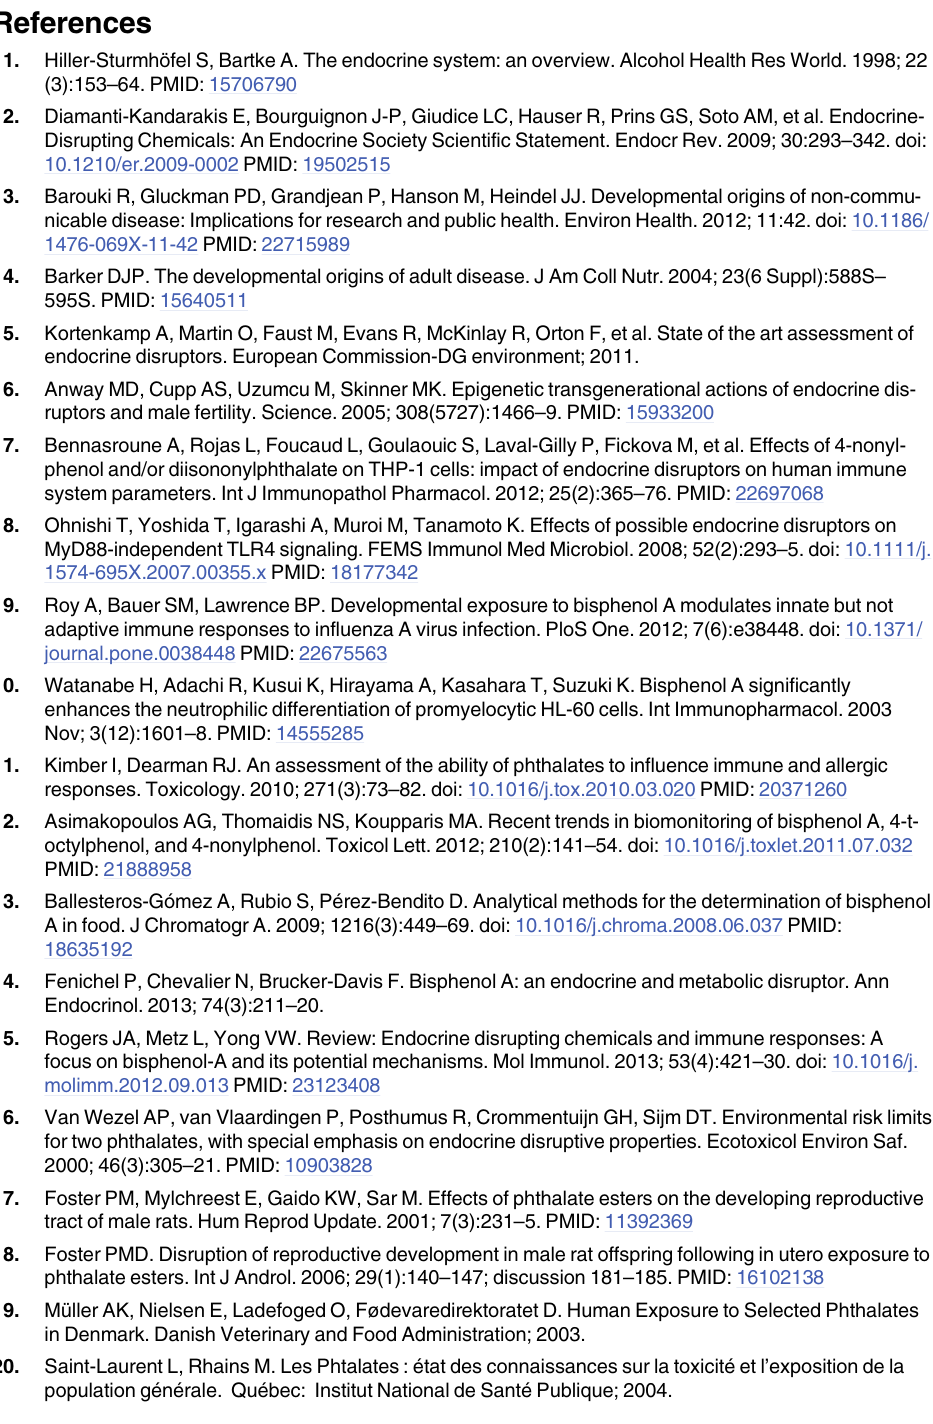
PLOS ONE | DOI:10.1371/journal.pone.0131428 July 2,